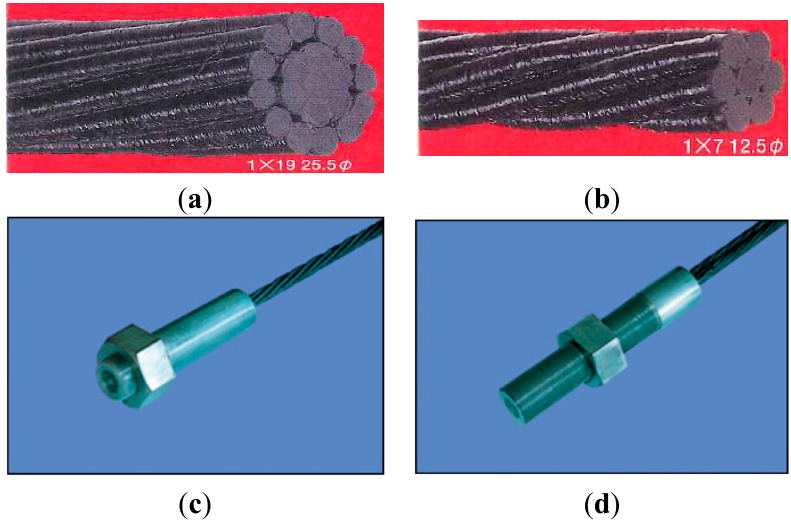
Figure 1. Optical images of standard CFCC (Tokyo Rope, [24]): ( a ) 19-strand, 25.5 mm diameter and ( b ) seven-strand, 12.5 mm diameter; ( c ) A terminal fixer for a single cable made by expansive material filling method (ES-type) and ( d ) a terminal fixer for multiple cables (EM-type). Reprinted with permission from reference [24]. Copyright 2013, Tokyo Rope.